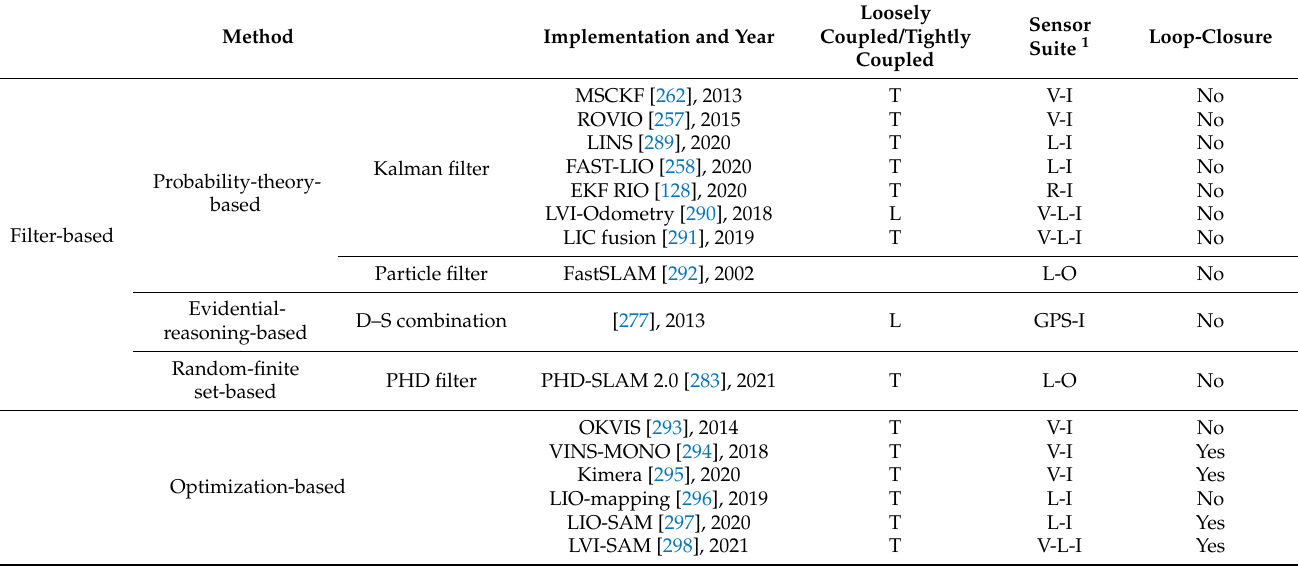
Table 7. Summary of representative multisensor fusion odometry